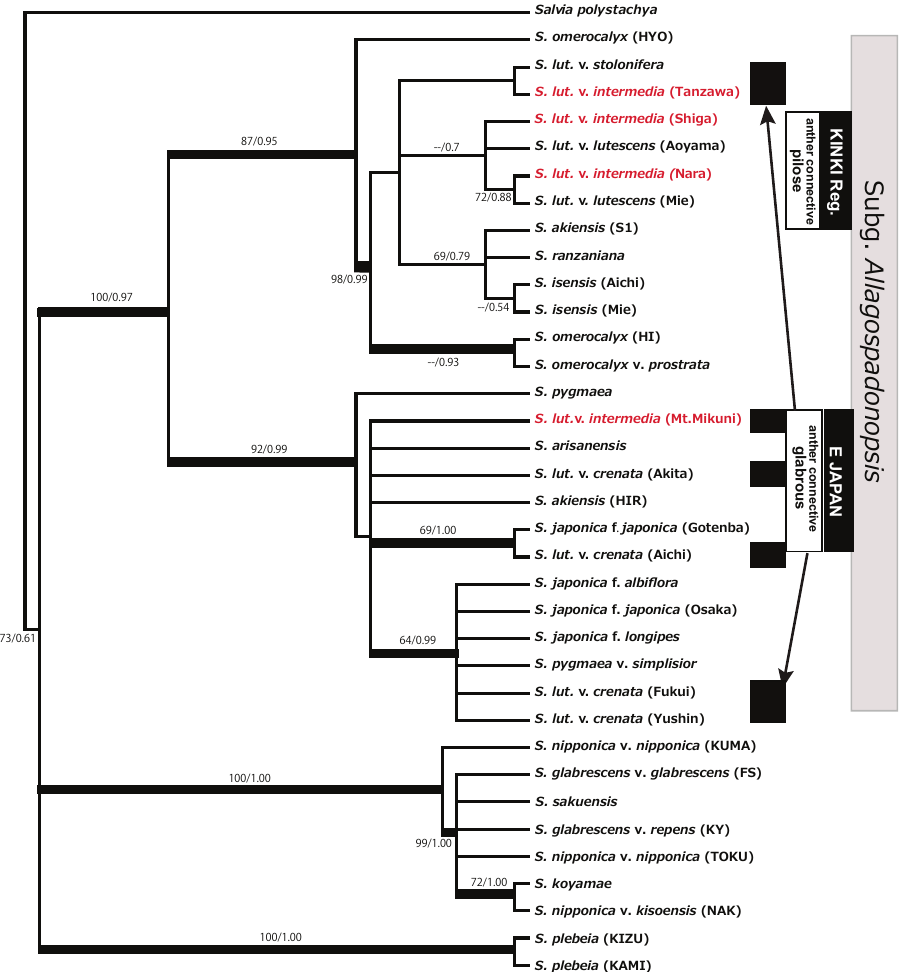
Figure 4. The Bayesian maximum clade credibility tree derived from plastid DNA (concatenate dataset of rbcL , trn L-F , ycf1-rps15 ). ML-bootstrap/Bayesian PP numbers are shown near the corresponding branch. Thick lines denote a clade that was strongly supported, with ML- bootstrap and/or Bayesian-PP greater than 95 %. ML: maximum likelihood; PP: posterior